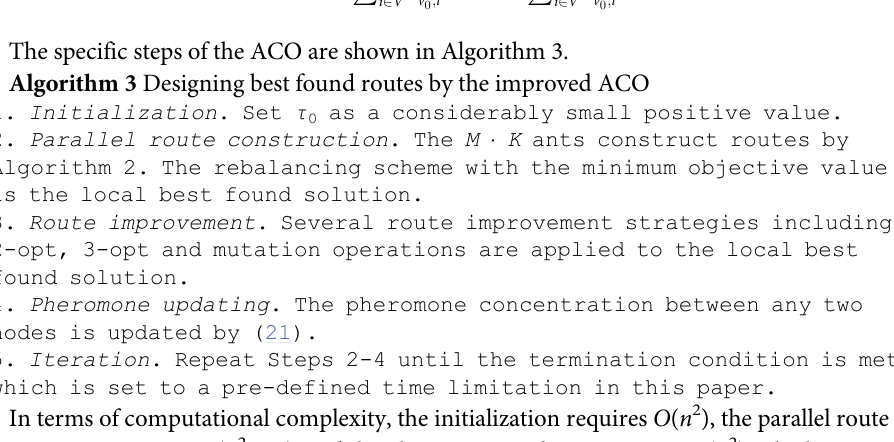
Algorithm 3 Designing best found routes by the improved